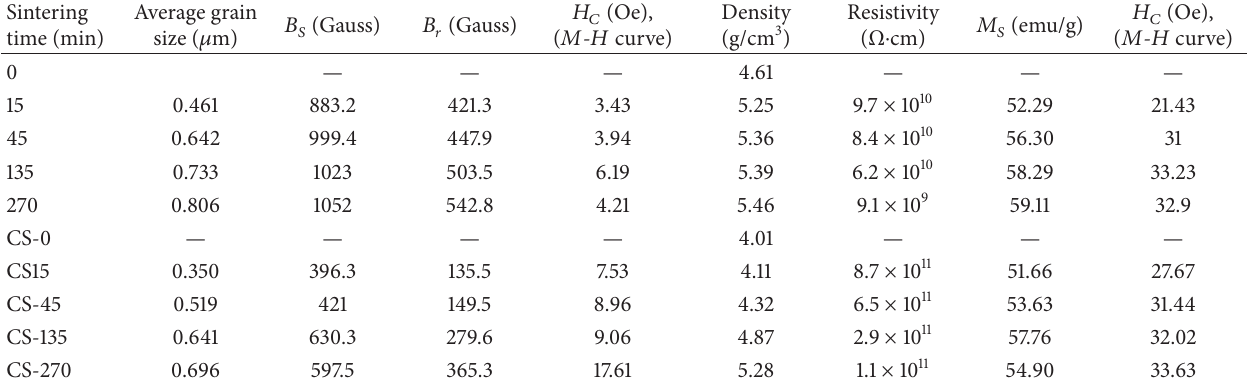
Table 1: Structural, electrical, and magnetic characteristics of the two types of samples at different sintering times. Sintering Average time (min)